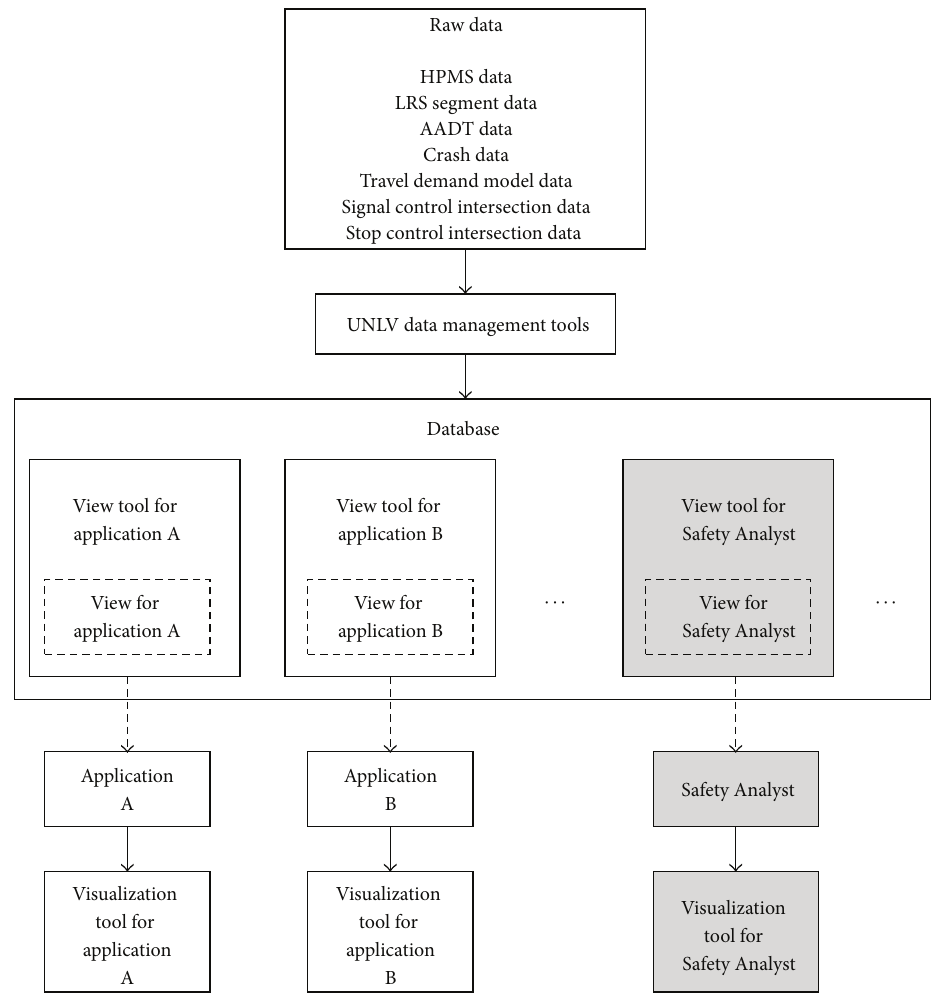
Figure 1: Conceptual framework for the comprehensive database and visualization system developed in this study.